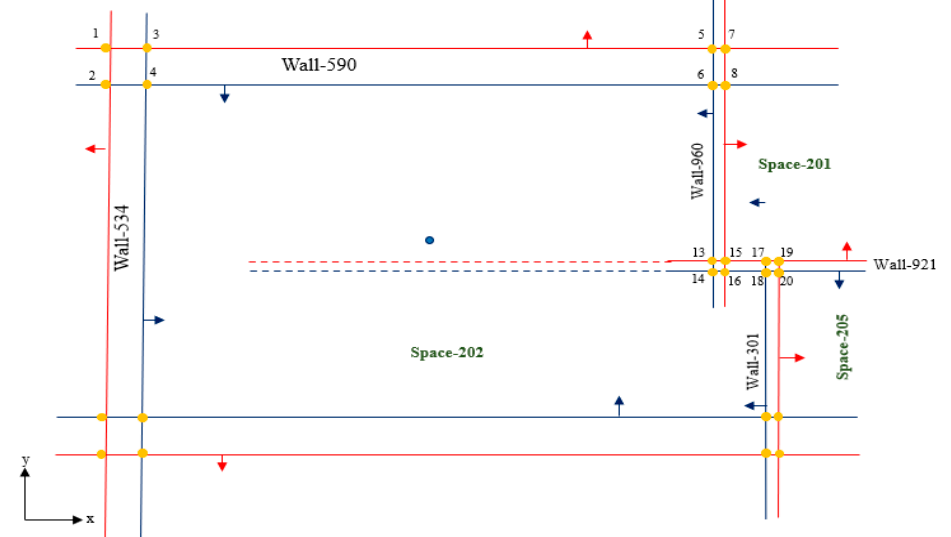
Figure 8. The 2D perspective of the face intersection of space-202. The arrows display the direction of the normal vector for each wall